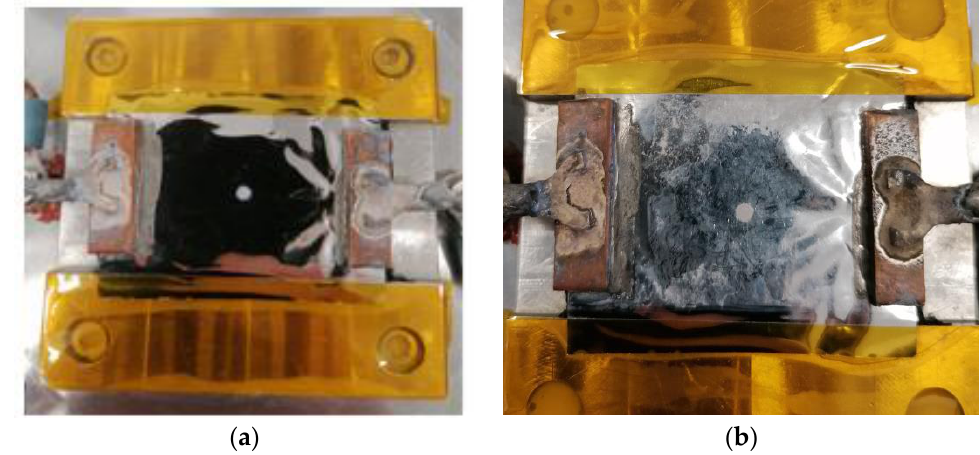
Figure 2. Test surface: ( a ) clean; ( b ) with deposited nanoparticles, after the experiment with 3 wt% concentration nanofluid .